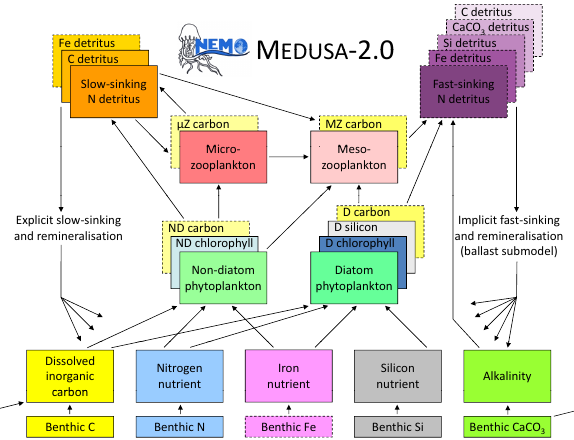
Fig. 1. Schematic diagram of the components and interactions in the MEDUSA-2.0 model. Boxes with solid borders indicate explicitly modelled state variables, while boxes with dashed borders indicate implicitly modelled components. Overlapping boxes indicate com- ponents for which multiple currencies are modelled (e.g. different elements, chlorophyll). The smaller boxes at the bottom of the di- agram refer to benthic reservoirs of model currencies that are fed by sinking detrital material (slow- and fast-sinking). Note that the dissolution of benthic CaCO 3 releases both DIC and